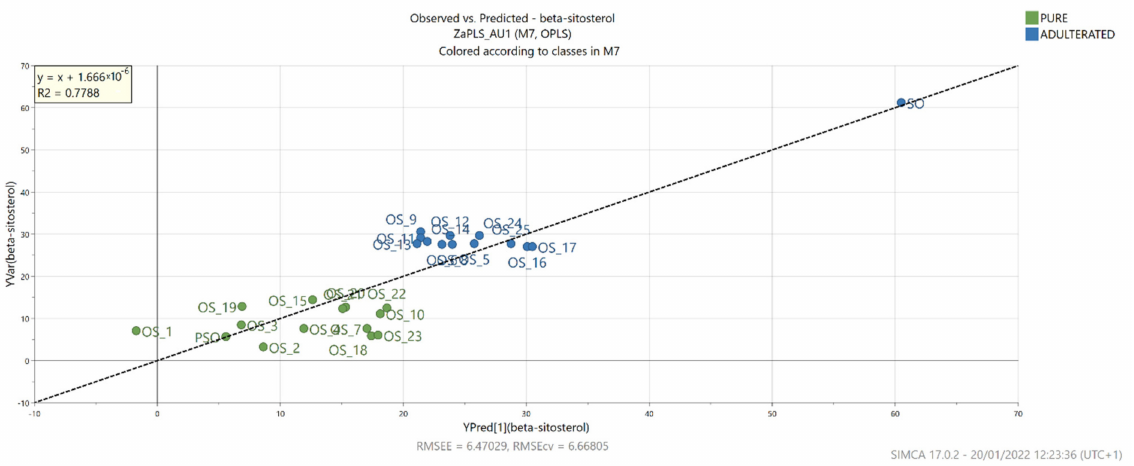
Figure 7. Actual and predicted β -sitosterol levels based on the OPLS model built with NIR spectrom- etry data.